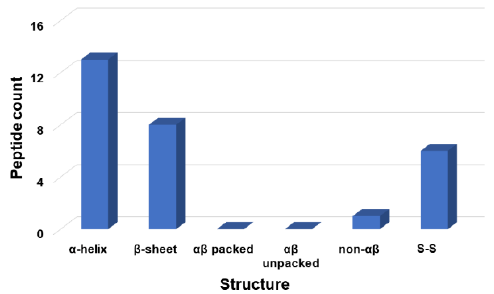
Figure 3. Count of antiviral peptides with different structures. Data were obtained from the antimi- crobial peptide database [25] for antiviral peptides with 11 – 20 amino acids. Antiviral peptides with an α -helical structure were dominant with 13 counts. In addition, there were eight antiviral peptides in the selected length group with β -sheet structures. No antiviral peptides in this length group had a determined αβ structure (packed or unpacked). Only one antiviral peptide in this group had a non- αβ structure. In addition, six antiviral peptides in this group were disulfide-linked (S-S), although their 3D structures are unknown. Note that a similar plot was obtained for antiviral peptides with 21–30 amino acids (not shown). Therefore, α -helical structure was decided as the most probable structure for this